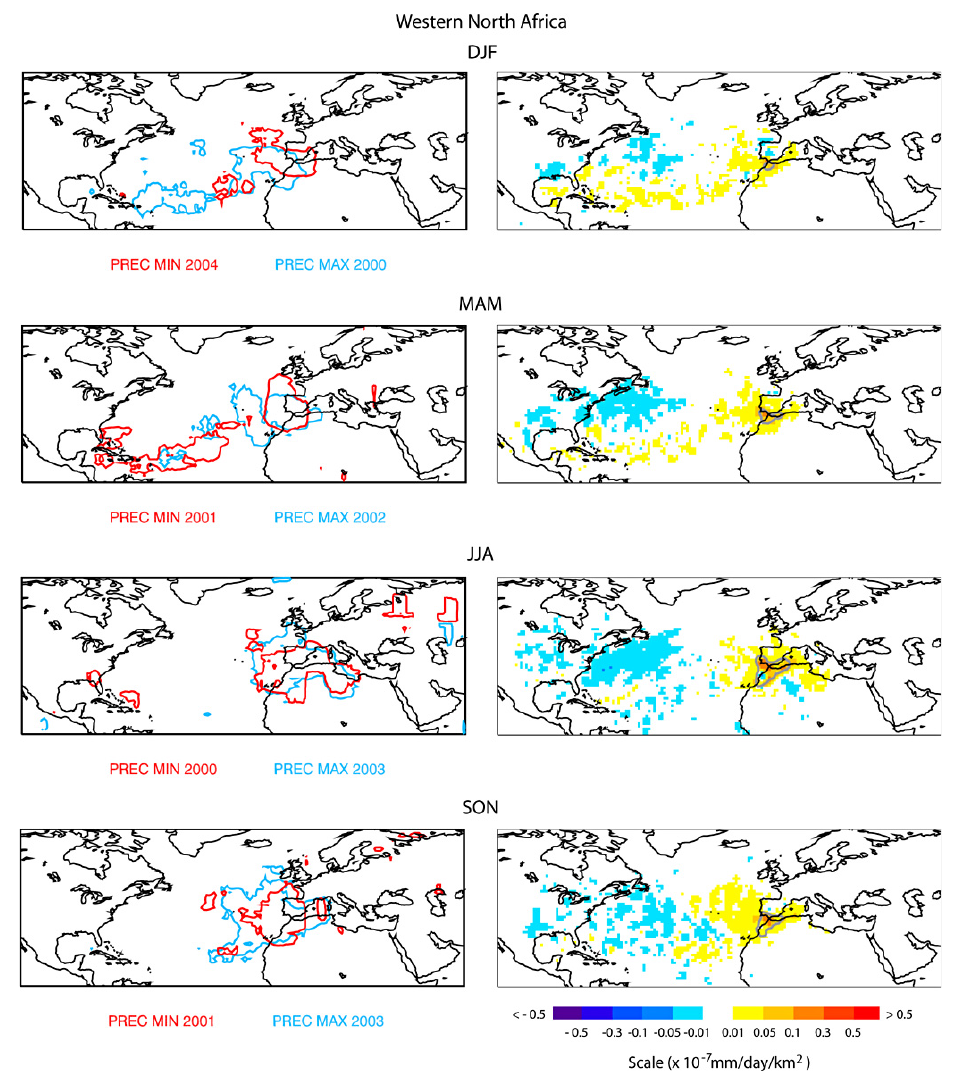
Fig. 9. As Fig. 2, but for the Western North Africa subregion (WA), considering its equivalent area as 439845km 2 .